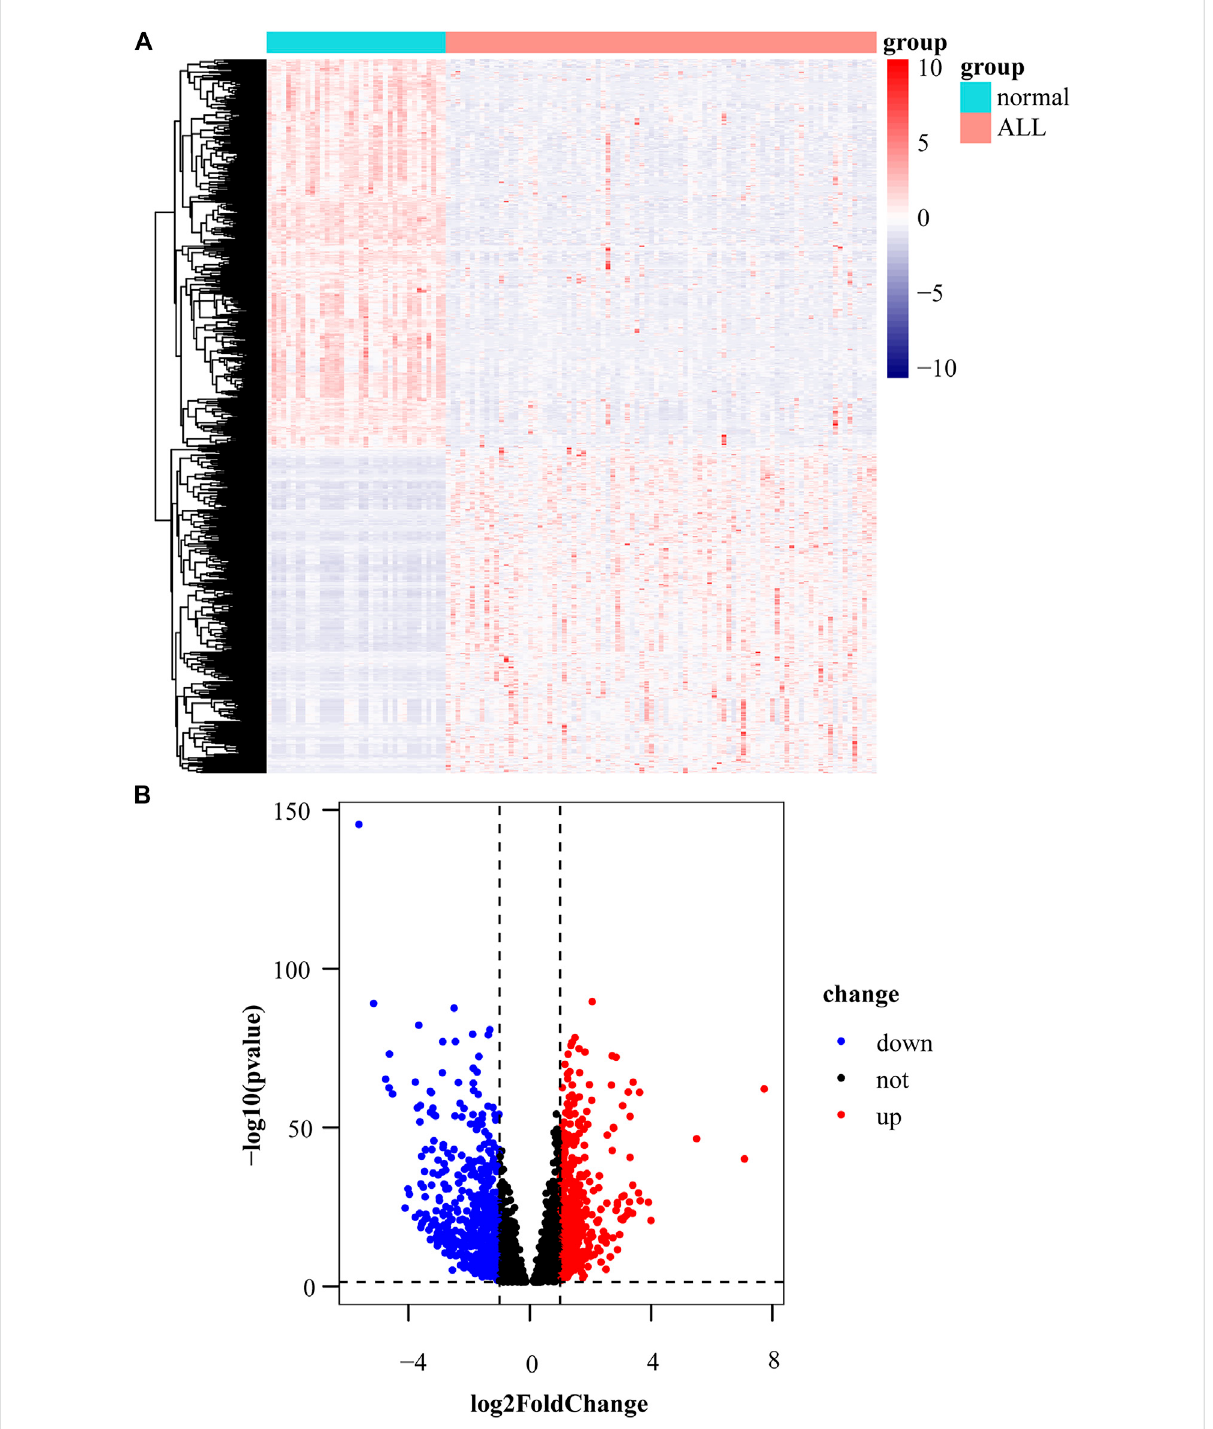
FIGURE 2 Identi fi cationofdifferentiallyexpressedgenes. (A) HeatmapofdifferentiallyexpressedgeneexpressionlevelsintheGDCTARGET-ALL dataset. (B) Volcano plot for differentially expressed gene expression levels in GDC TARGET-ALL